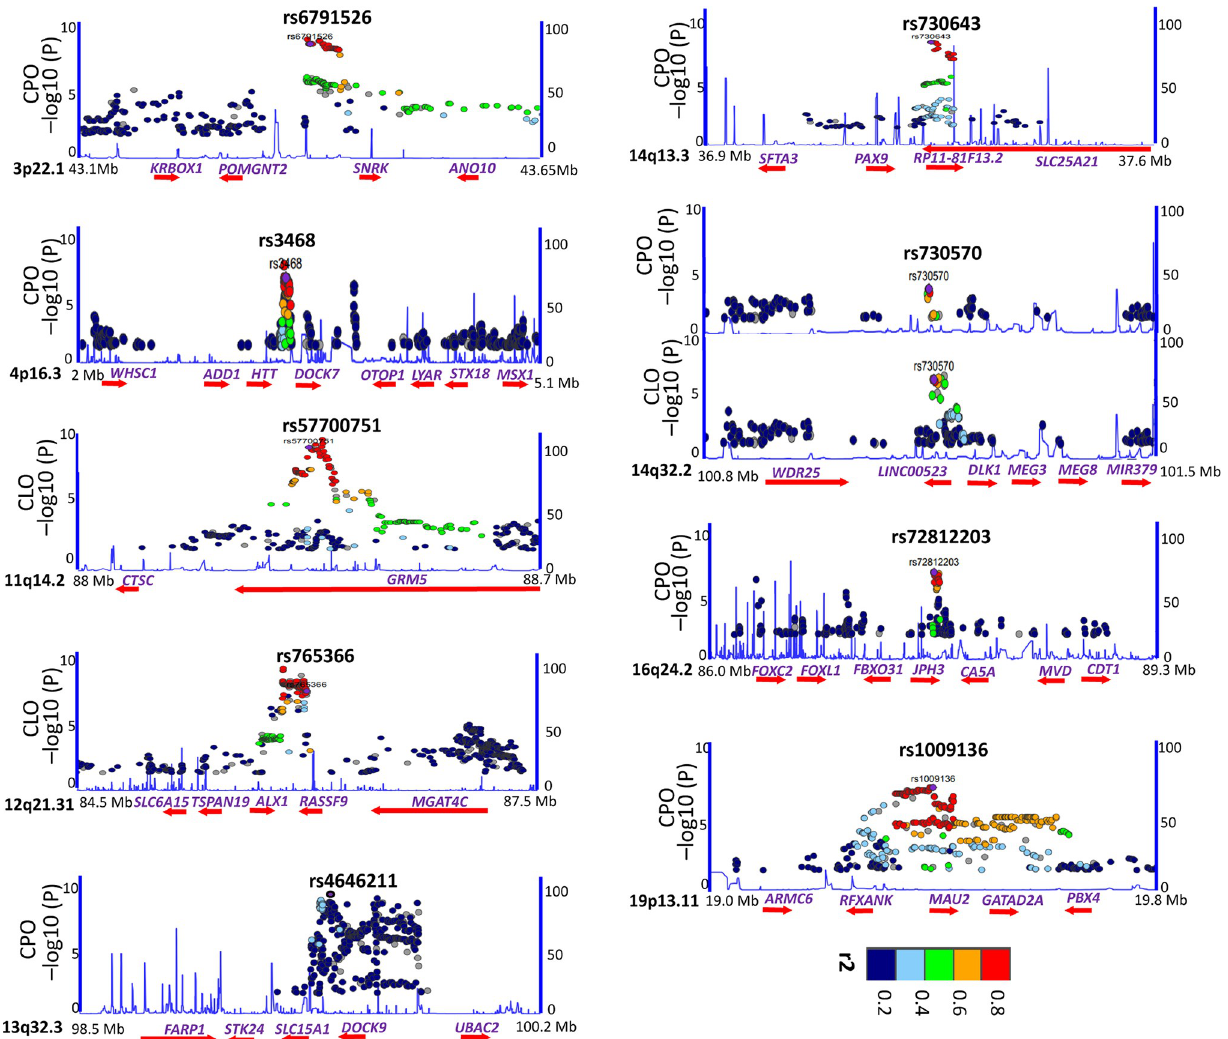
Fig 2. Regional association for the nine newly discovered loci by typical GWAS. Regional association plots indicate the − log 10 P values of the genotyped SNPs of each locus. The sequence data were aligned to human hg19. The Y axis represents the negative logarithm (base 10) of the SNP P value and the X axis represents the position on the chromosome, with the name and location of genes in the UCSC Genome Browser shown in the bottom panel. The SNP with the lowest meta analyzed P value in the region was marked by a purple star. The colors of the other SNPs indicate the r 2 of these SNPs with the lead SNP. Plots were generated with LocusZoom using hg19/1000 genome build LD for ASN population